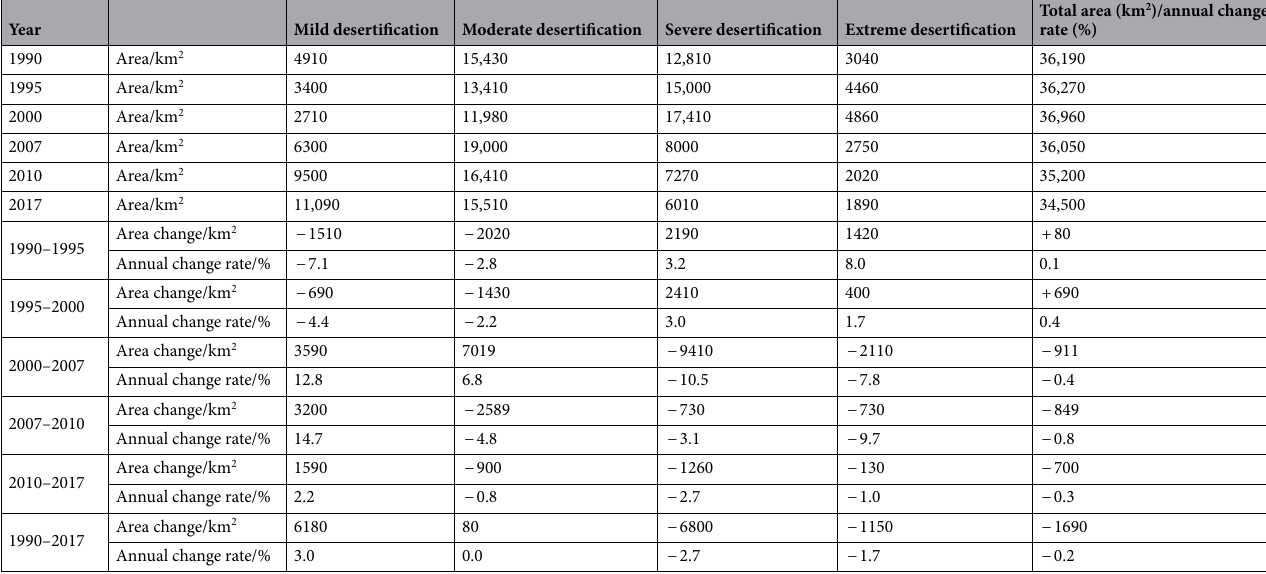
Table 1. Desertification land area of Mu Us sandy land and its changes in different